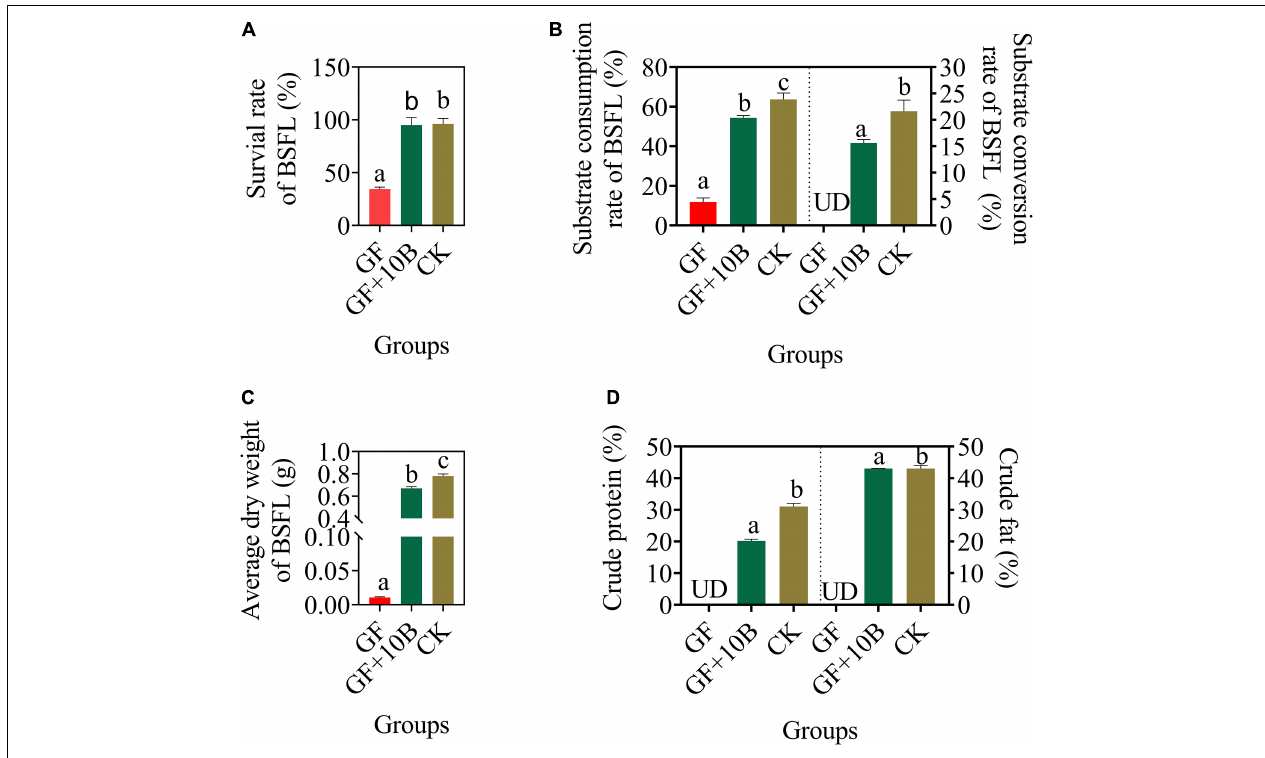
FIGURE 5 | The bio-physiological parameters, namely, (A) survival rate, (B) substrate consumption/conversion rate, (C) average dry weight, and (D) crude protein/fat content of BSFL in the GF, GF + 10B, CK groups. GF, germ-free BSFL fed on sterile food waste; GF + 10B, germ-free BSFL fed on sterile food and 10B; CK, natural BSFL fed on sterile food waste. Data are shown as mean ± standard deviation ( n = 3). Values with different letters mean significant differences at p < 0.05, as determined by Tukey’s test. UD,